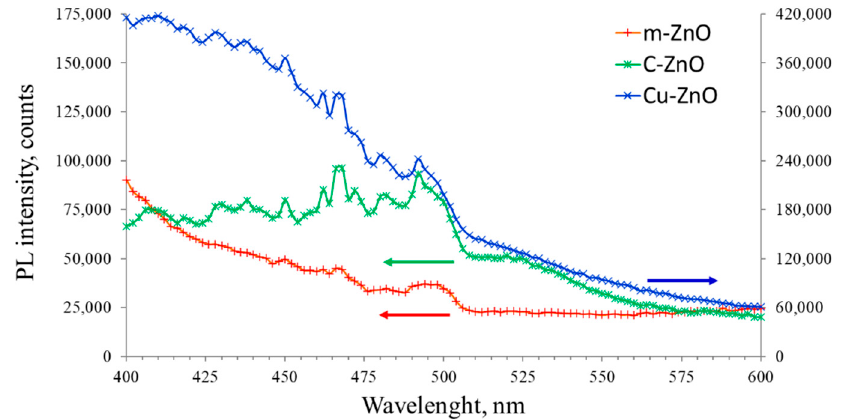
Figure 6. Photoluminescence of m-ZnO, Cu-ZnO and C-ZnO samples. PL spectroscopy measure- ments were performed using 340 nm excitation source. Arrows indicate intensity scales of the corresponding PL spectra.